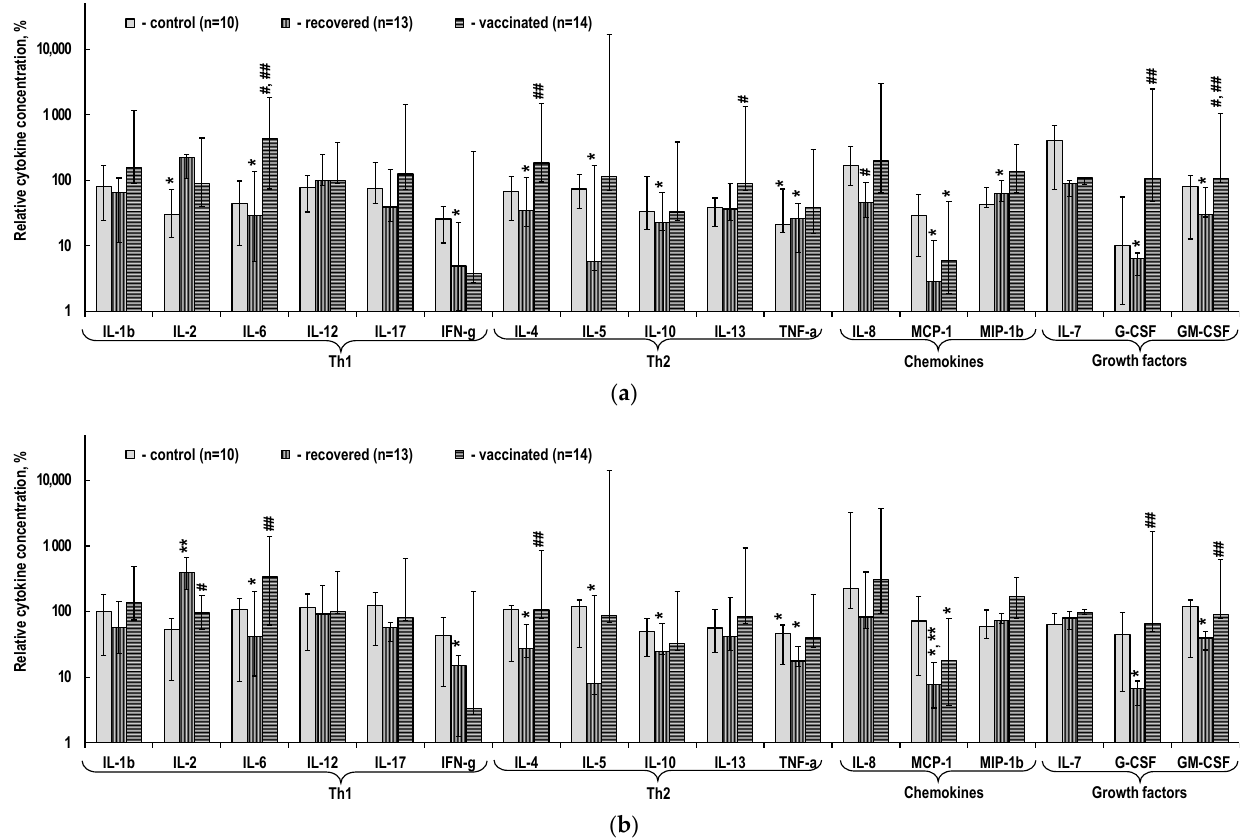
Figure 6. Cytokine content in the PBMC culture medium with specific stimulation by SARS-CoV-2 peptides. ( a ) AG1 peptides stimulation. ( b ) AG2 peptides stimulation. The relative cytokine concentration is the ratio of the measured absolute concentration of a cytokine in a sample to the median absolute concentration of this cytokine in samples without PBMC stimulation in this group. * p < 0.01 when comparing samples without stimulation to samples with non-specific stimulation within a group. ** p < 0.01 when comparing samples with specific stimulation using various sets of SARS-CoV-2 peptides within a group. # p < 0.01 when comparing samples with non-specific stimulation between the group of interest and control group. ## p < 0.01 when comparing samples with similar non-specific stimulation between the groups of vaccinated and recovered